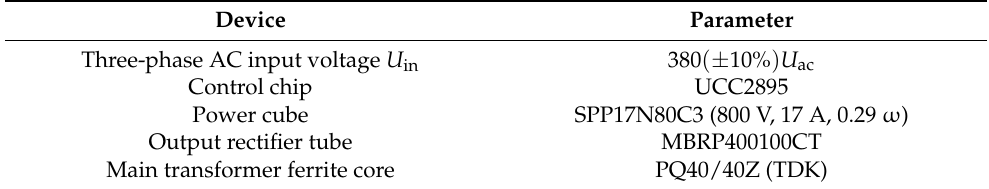
Table 2. The prototype parameters.